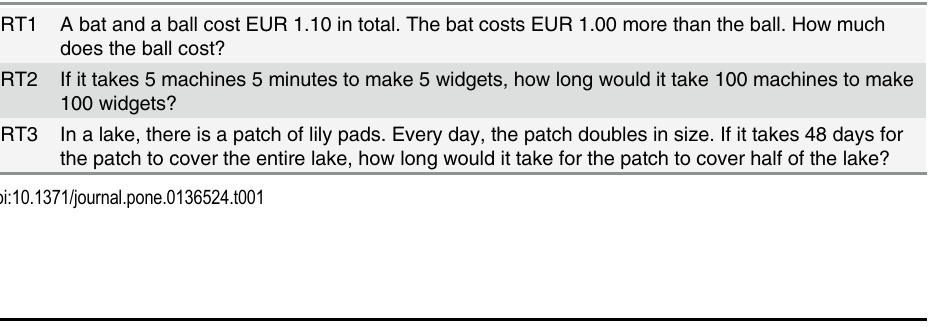
Table 1. The cognitive reflection test